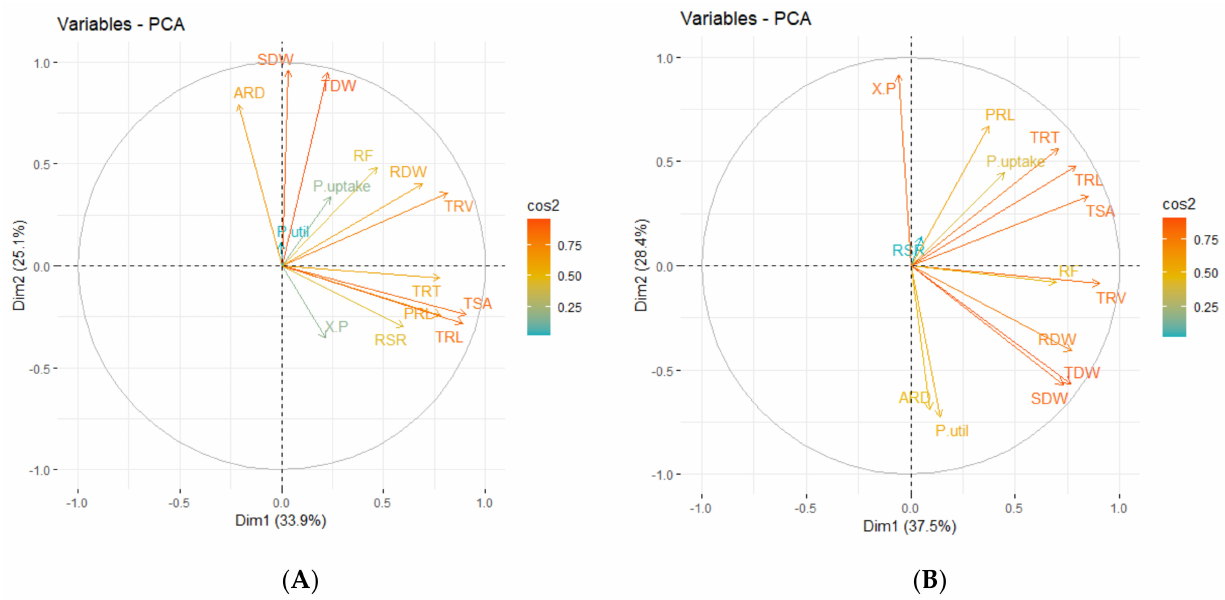
Figure 2. ( A ) Biplot PupE and ( B ) Biplot PutiE using the relative values of tested root and shoot traits of Vigna species under LP conditions (PupE, phosphorus uptake efficiency; PutiE, phosphorus utilization efficiency; LP, low